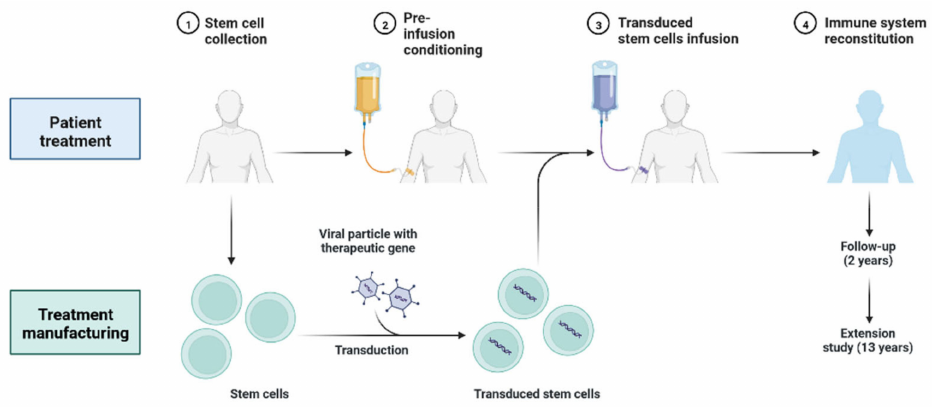
Figure 22. Gene Therapy Treatment